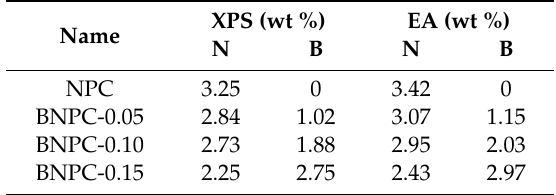
Table 1. Textural properties and elemental content of the NPC and